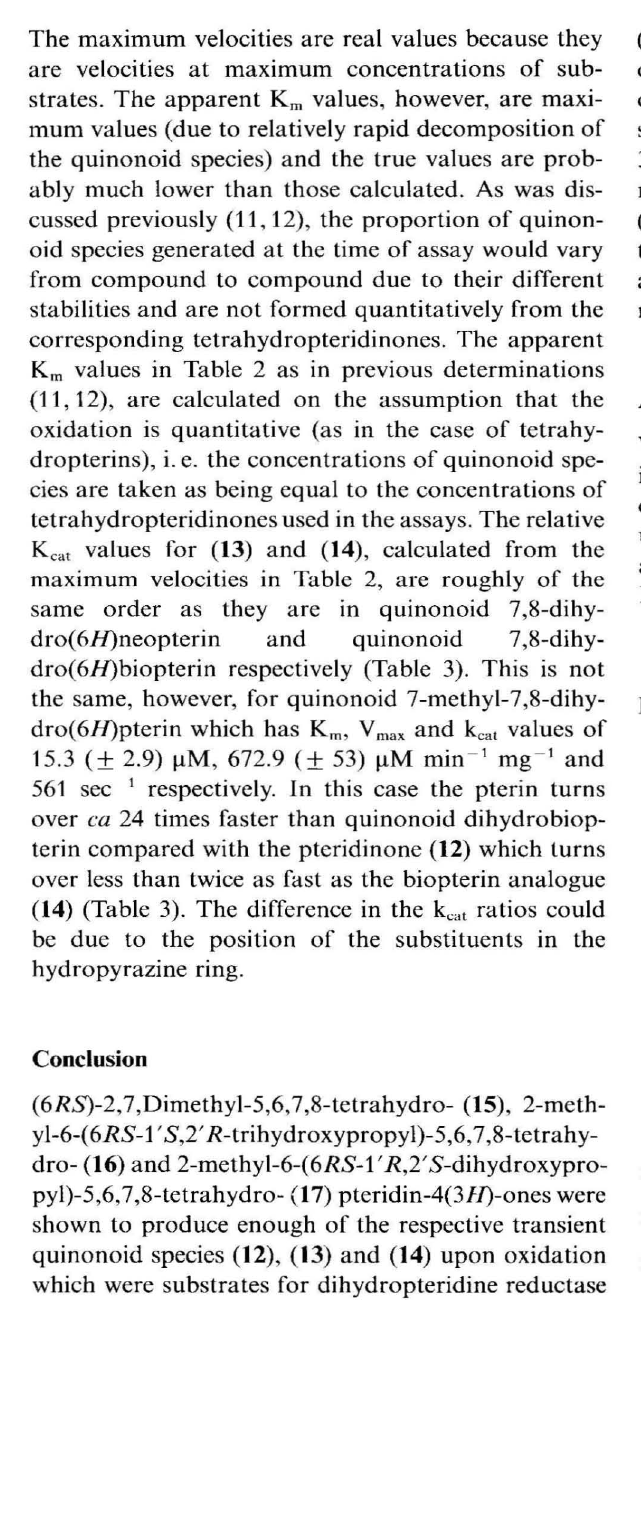
Table 3. Comparison of K c", values of dihydropteridine reductase (human) at pH 7.4 and 25 DC"